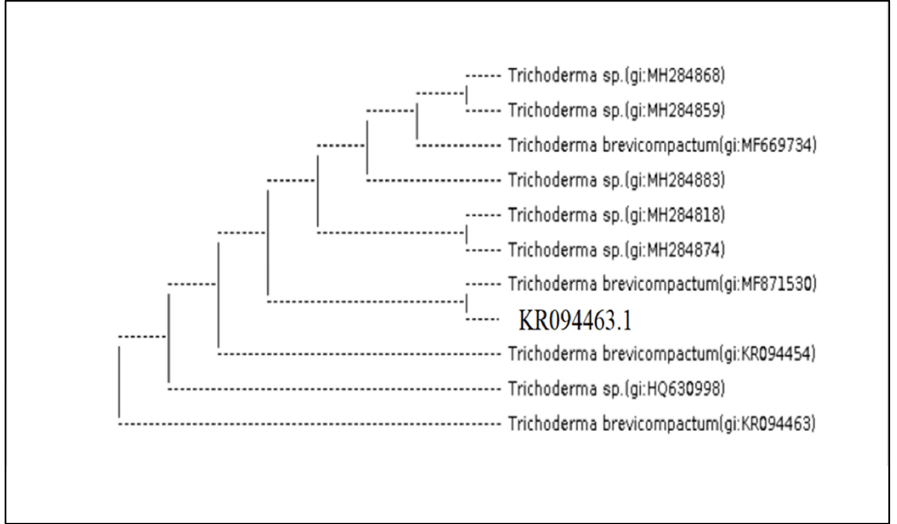
Figure 4. Trichoderma isolate (A (3) 3.1 T) (analysis of 18S rDNA of the T. brevicompactum (KR094463.1), with primers ITS4 and ITS5 in NCBI GenBank respectively).